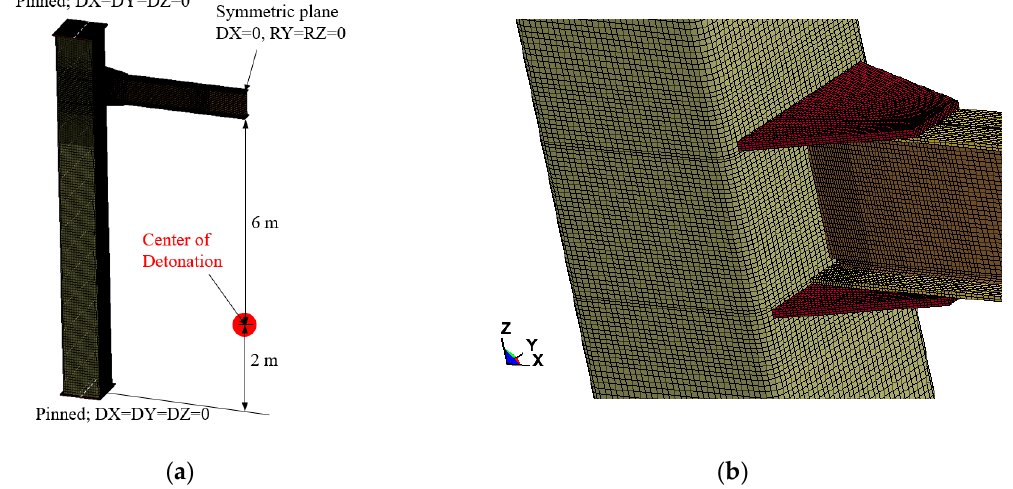
Figure 4. Numerical model of plate-reinforced large CFT column-H-section beam connection. ( a ) Beam, column and connection model; ( b ) mesh in the vicinity of connection.